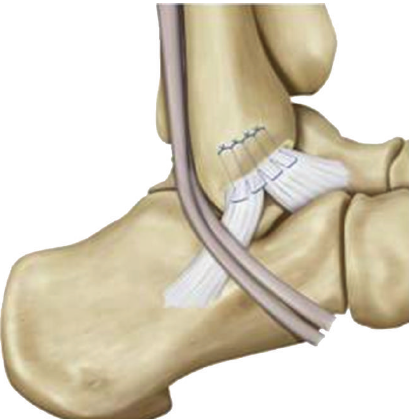
Figure 1: Our modified Brostr¨om method. Decortication was performed to improve the possibility of union between bone and ligament. And the remnant of the ATFL and CFL was sutured to their original attachment to the fibula through the “pull put technique” with the ankle in neutral